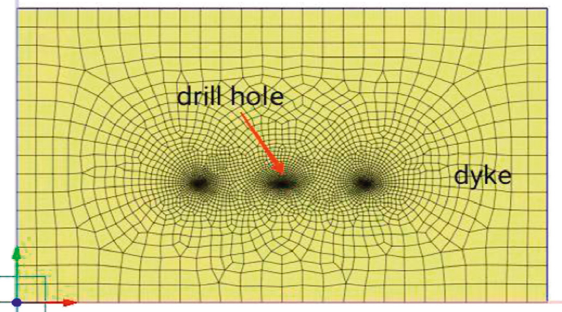
Figure 14: Blasting hole model of chamber rock